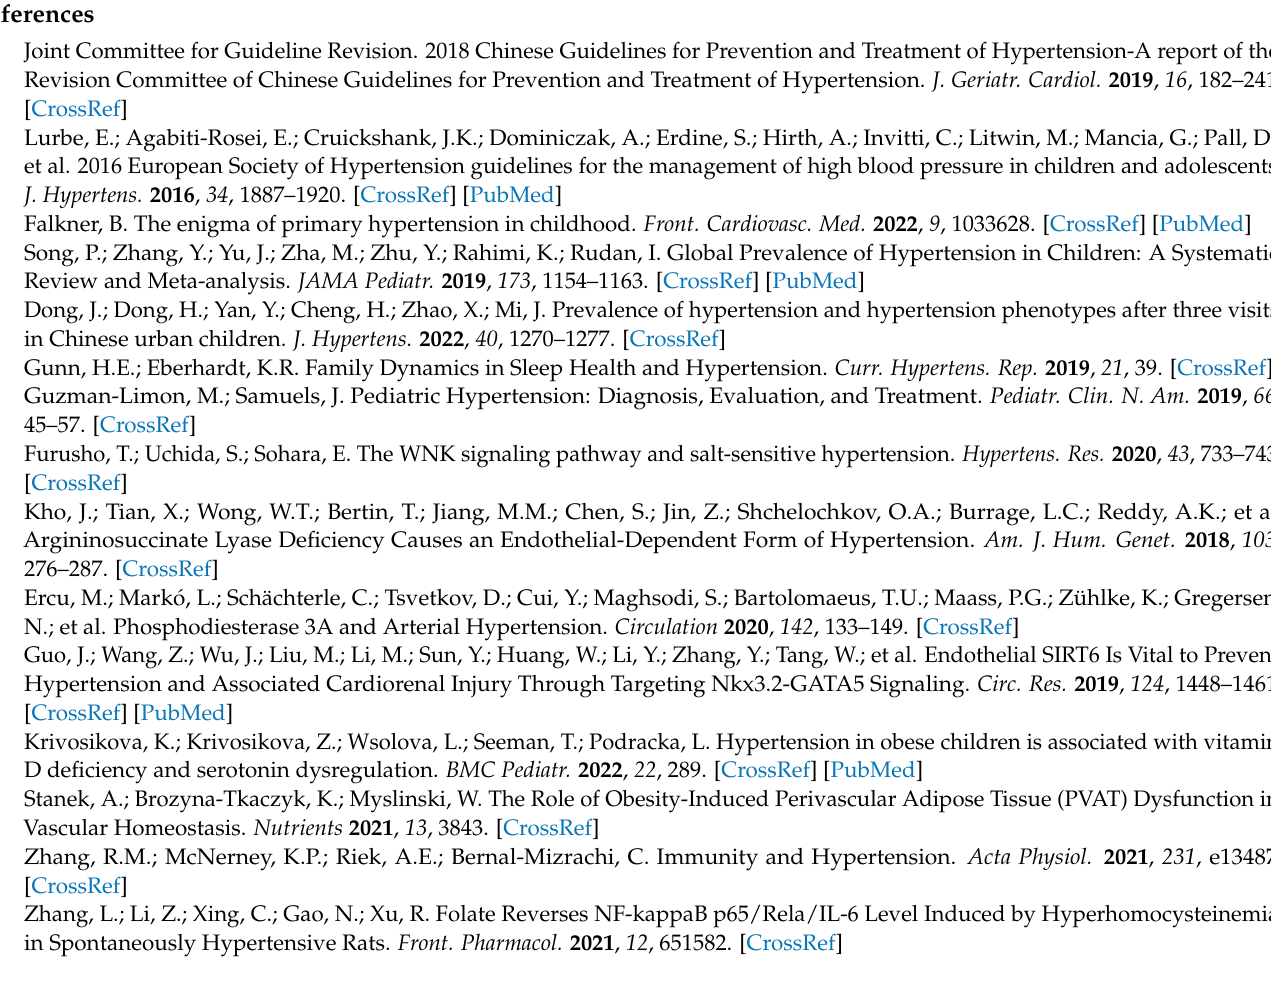
Figure S3: KEGG pathway map of insulin resistance. Figure S4: Pathway diagram related to